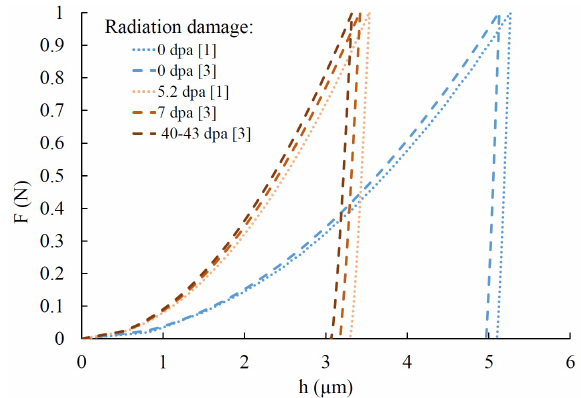
Figure 4. Simulated indentation curves using a 2D model for non- and neutron-irradiated material, me- chanical properties determined at room temperature